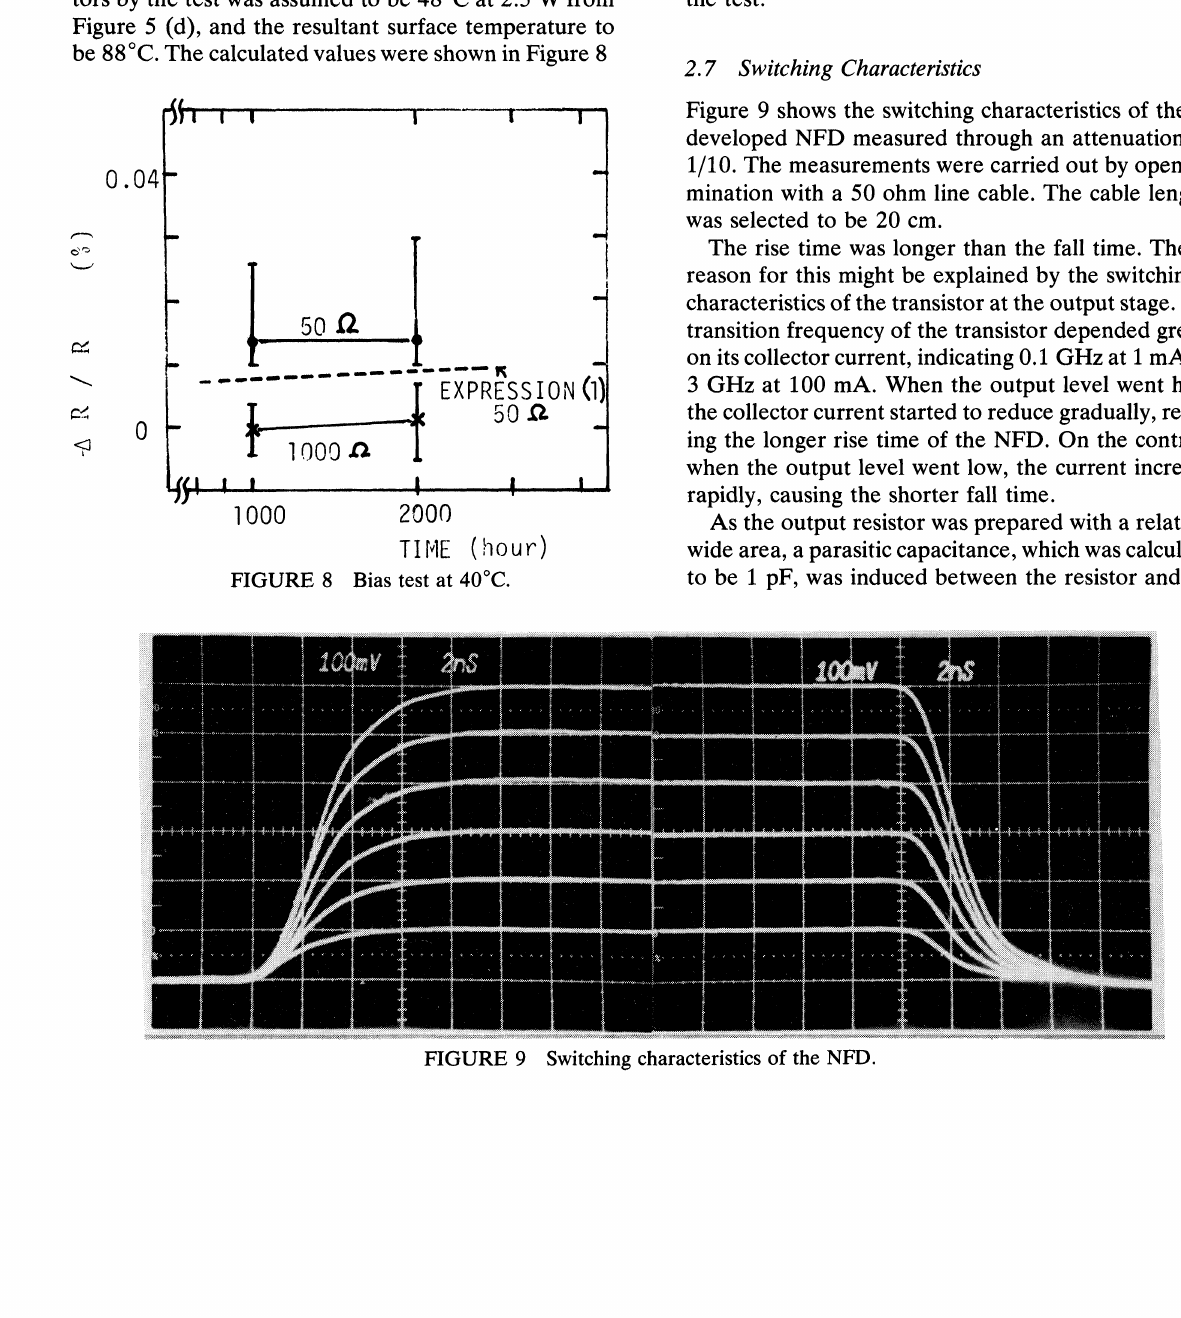
FIGURE 8 Bias test at 40C.